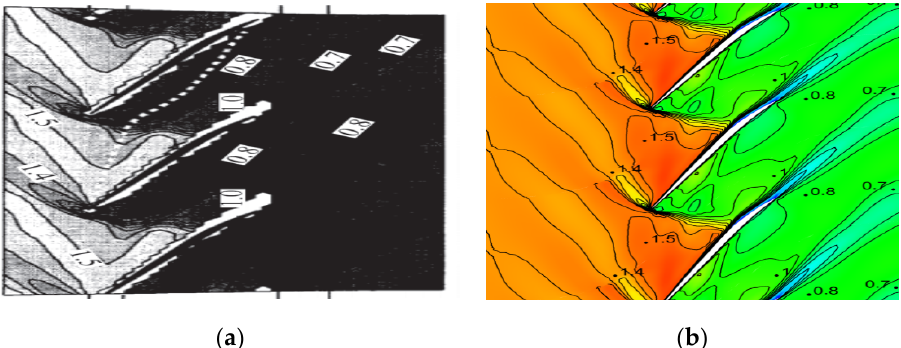
Figure 3. The comparison of the relative Mach number at a 95% span at the maximum efficiency point. ( a ) The experimental results; ( b ) the numerical simulation results.